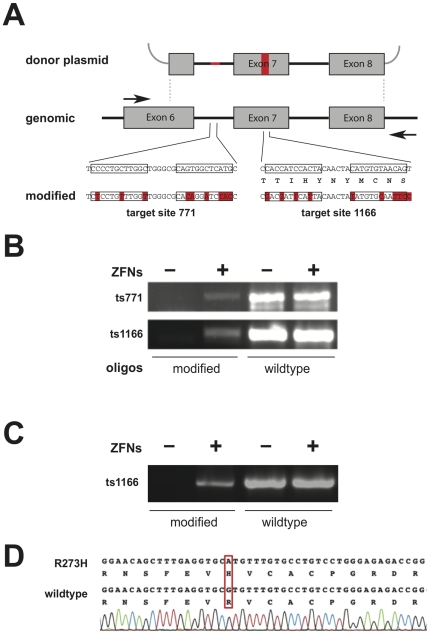
Targeted genomic recombination with p53 donor plasmid.(A) Schematic of the genomic p53 locus and the donor plasmid, with modified DNA sequences at z771 and z1166 target sites (“barcodes”; highlighted in red). Barcodes allow selective PCR but do not change the p53 protein sequence. Black arrows indicate primers for genomic PCR that hybridize to the chromosomal p53 locus outside of the region corresponding to donor sequence. (B) Targeted donor plasmid recombination into the p53 z771 and z1166 loci in HEK293T cells. ZFN-induced recombination is shown by semi-nested PCR, on purified external genomic PCR template, with forward primers that discriminate between wild-type and barcode sequence. (C) Targeted donor recombination at the p53 z1166 locus in human SF268 glioblastoma cells. (D) Restoration of p53 wild-type sequence at codon 273 in ZFP-treated SF268 glioblastoma cells. The relative positions of the z1166 cutting site and codon 273 are indicated in Fig. 1B.